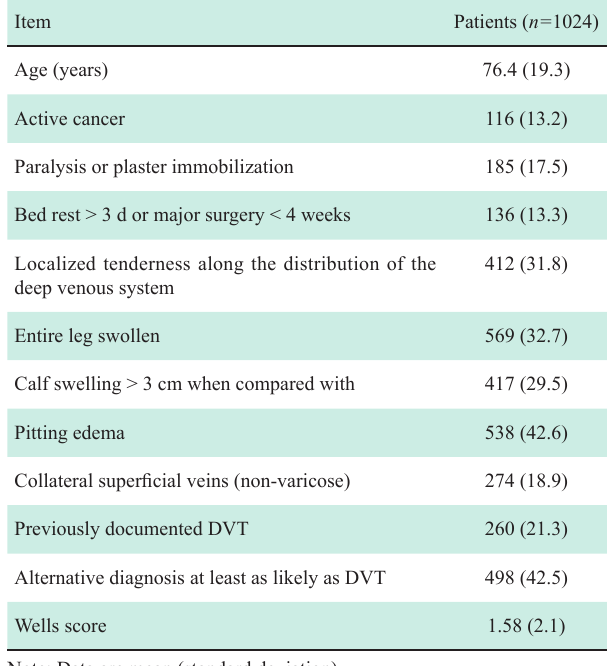
Table 2 Baseline characteristics of patients suspected with